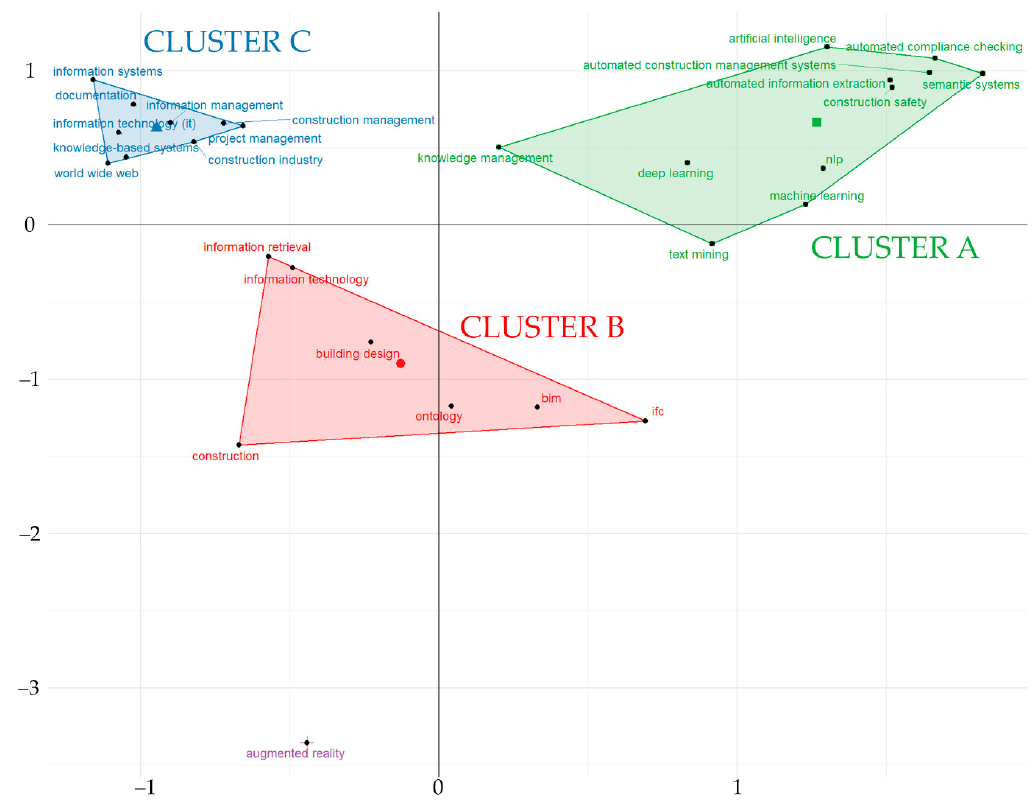
Figure 11. Factorial analysis reduction 2D map. Software: BiblioShiny version 3.0. Table 6. Relevant papers about NLP application for Safety and Risk mitigation, and Automated Compliance Checking task. Topic Risk